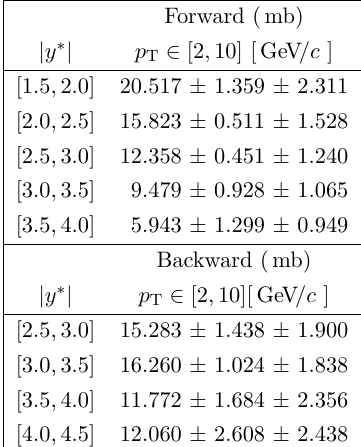
Table 3 . Di(cid:11)erential cross-section (in mb) for prompt (cid:3) + forward and backward data. The (cid:12)rst uncertainties are statistical and the second are systematic.